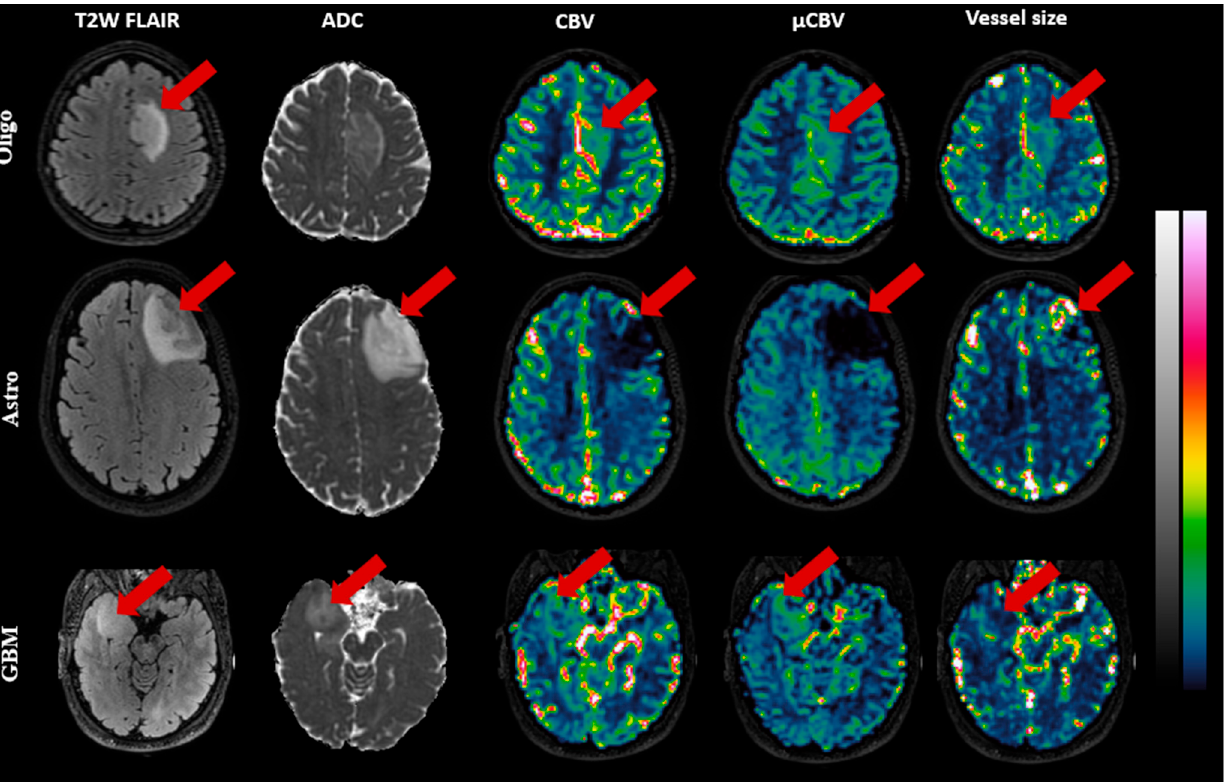
Figure 3. Exemplary MR images of three patients, Oligo (IDH-mut &1p/19q co-deleted), Astro (IDH-mut), and GBM (IDH-wt), respectively, from top to bottom. The images (with color bars on the right) from left to right, respectively, are: T2W-FLAIR, ADC (0–1 µm 2 /s), CBV(0–10%), µCBV(0–10%), and vessel size (0–100 µm), with the red arrow pointing to the tumor. Table 2. Group averages of CBV, µCBV, and vessel size in the three glioma subtypes: Oligo (IDH- mut&1p/19q-codeleted), Astro (IDH-mut), and GBM (IDH-wt). a : one-way ANOVA test; b : Krus- kal–Wallis test. The bold formatting indicates a significant p -value.